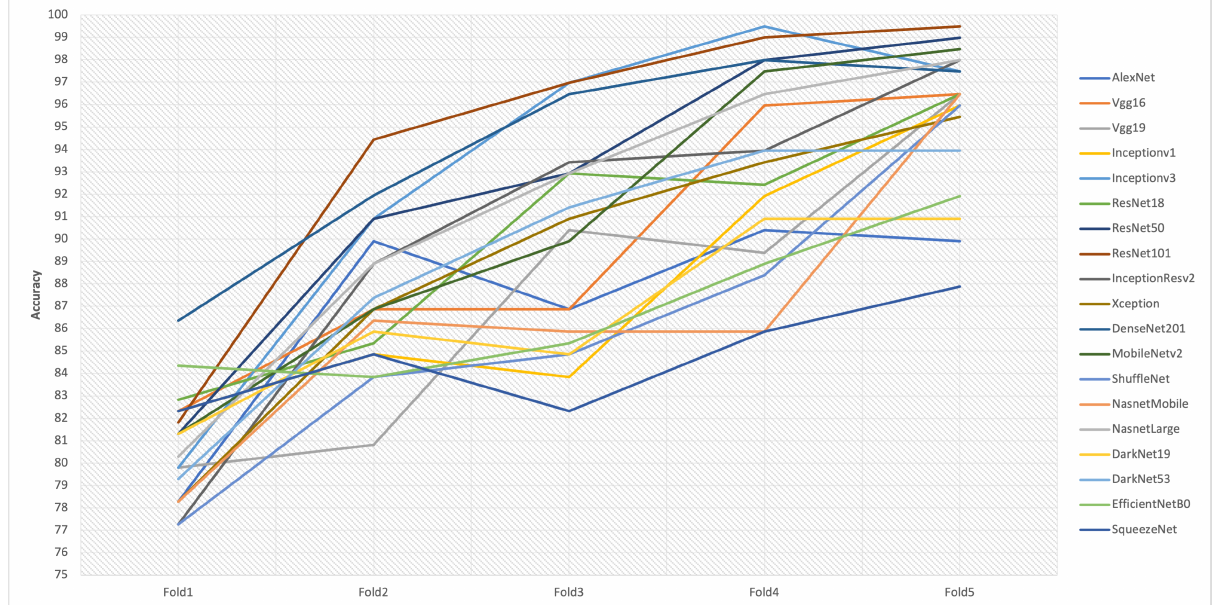
Figure 3. The obtained accuracies over five folds in the nineteen CNN models. It shows that there is no superior CNN model over others due to the lack of a CNN model that achieves the best accuracies through the five folds. This would lead to difficulty selecting the best model while considering another conflicting criterion, such as the network